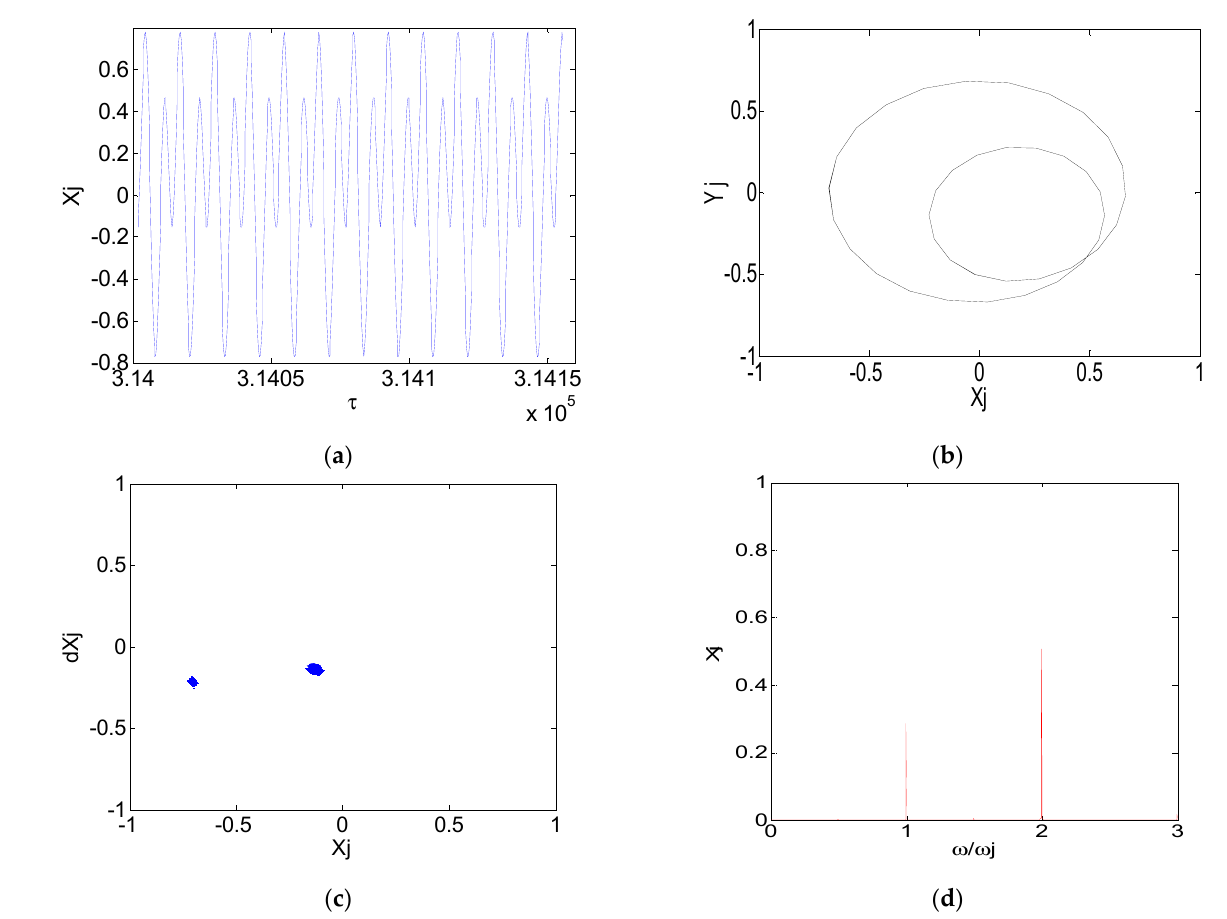
Figure 7. Dynamic response of the floating ring system λ = 0.01 and speed ratio is S = 1.58: ( a ) time-domain waveform; ( b ) orbit; ( c ) Poincare section; ( d ) the FFT spectrum of the disk .